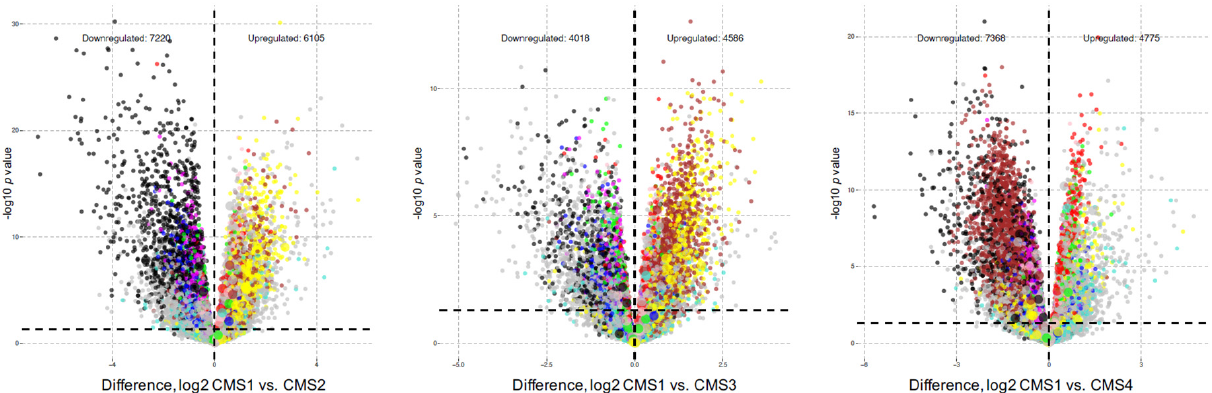
Figure 3. Volcano plots of differential gene expression identifies gene transcripts that contain upregulated genes and downregulated genes based on CMS status for each module. The number of downregulated gene transcripts is denoted on the left and number of upregulated gene transcripts is denoted on the right. The X axis represents the Log 2 fold-change and the Y-axis represents the negative Log 10 p -value. Gene transcripts are colored by module membership (light grey dots, no module assignment).